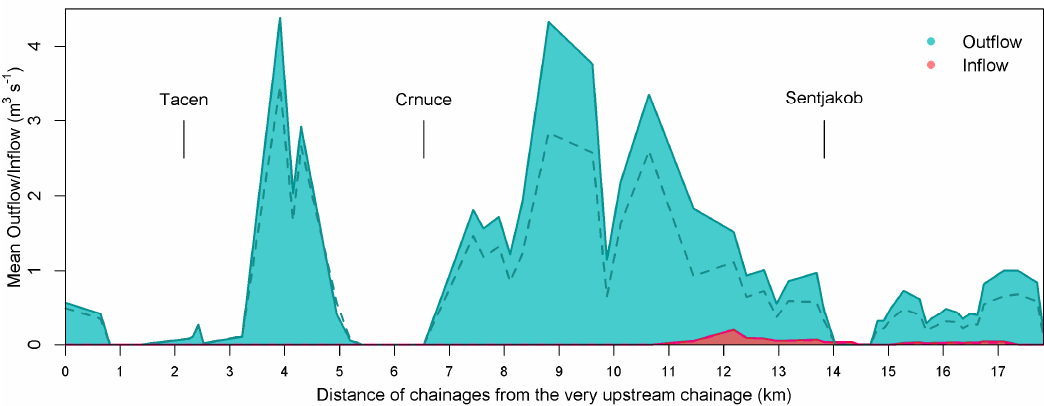
Figure 12. The Sava River water-groundwater interactions areas, and mean seepage of river water into the aquifer (inflow) and vice versa (outflow) during 2010 (full line) and 2011 (dash line). Groundwater flow under different conditions, including high (2 November 2010) and low (1